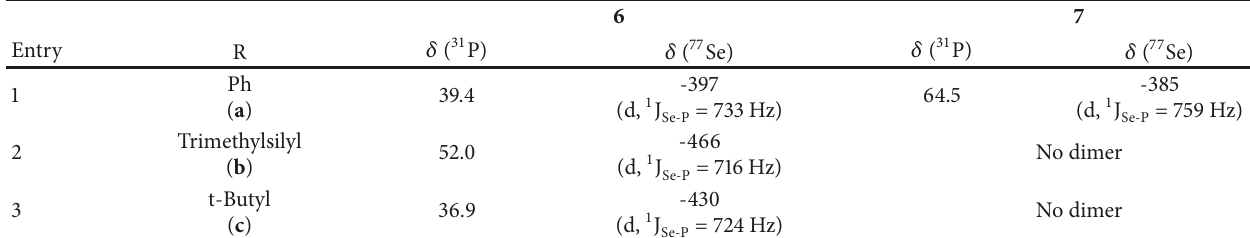
Table 5: 31 P and 77 Se NMR chemical shifts (ppm) (CDCl 3 ) and coupling constants of 6 and 7